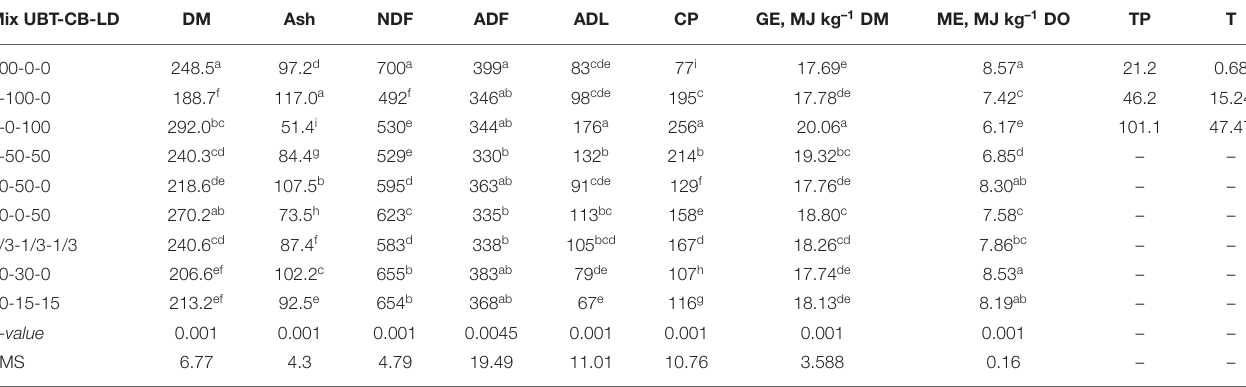
TABLE 2 | Mean chemical composition of Urochloa brizantha cv. Toledo (UBT) and the two forage legumes, C. brasiliensis (CB) and L. diversifolia (LD), and their mixed proportions used in the study. Mix UBT-CB-LD